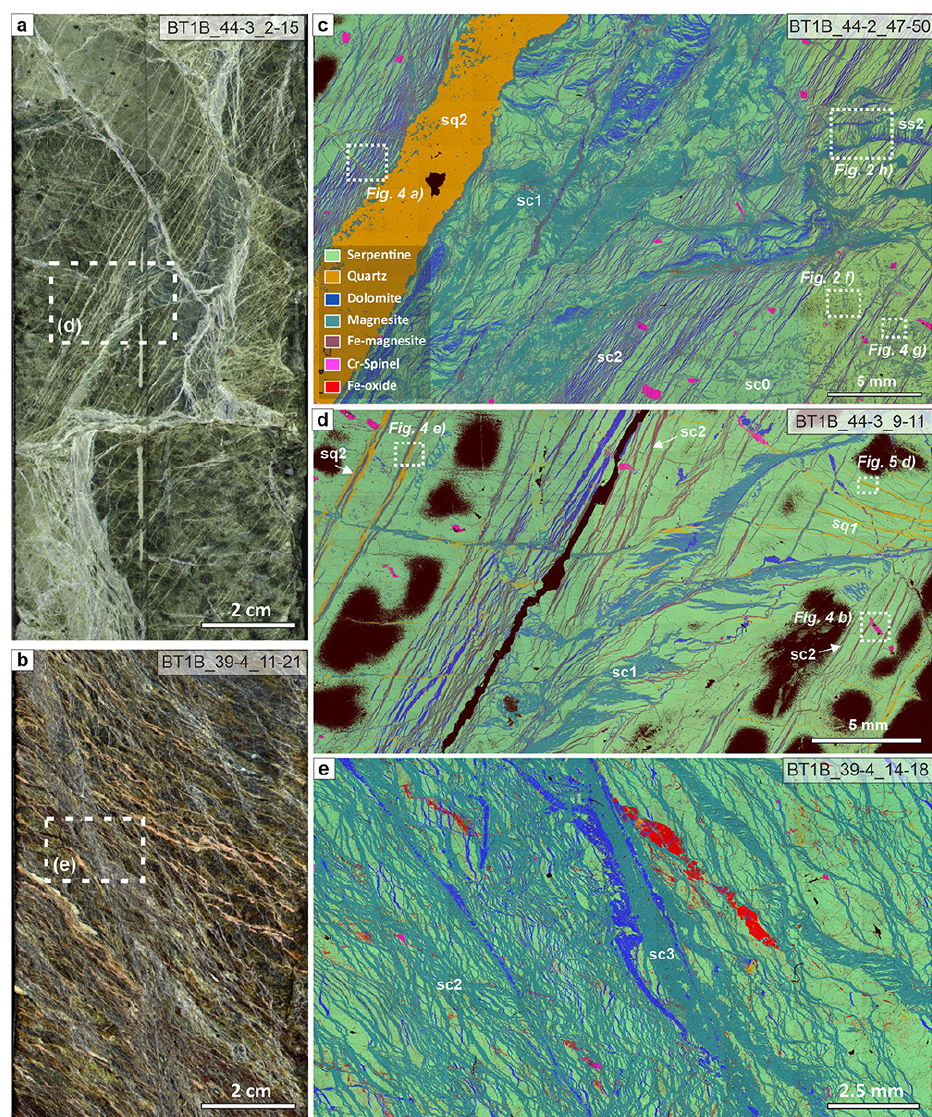
Figure 3. Veins in serpentinite of Hole BT1B. (a) Split-core image of serpentinite with closely spaced, parallel carbonate veins. (b) Split- core image of strongly veined serpentinite interval with anastomosing carbonate veins. (c–e) Composite-color EDX maps of carbonate-rich serpentinites showing different carbonate (sc1–sc3) and quartz (sq1, sq2) vein generations (common legend in c ). Black patches in (d) are areas where soft bastite serpentine were lost during sample preparation. Core diameter in (a) and (b) is